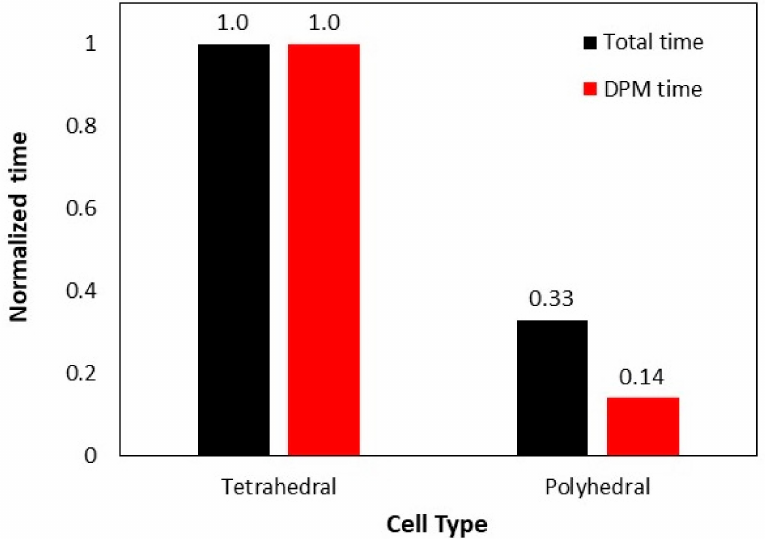
Figure 7. Simulation time for different cell type.